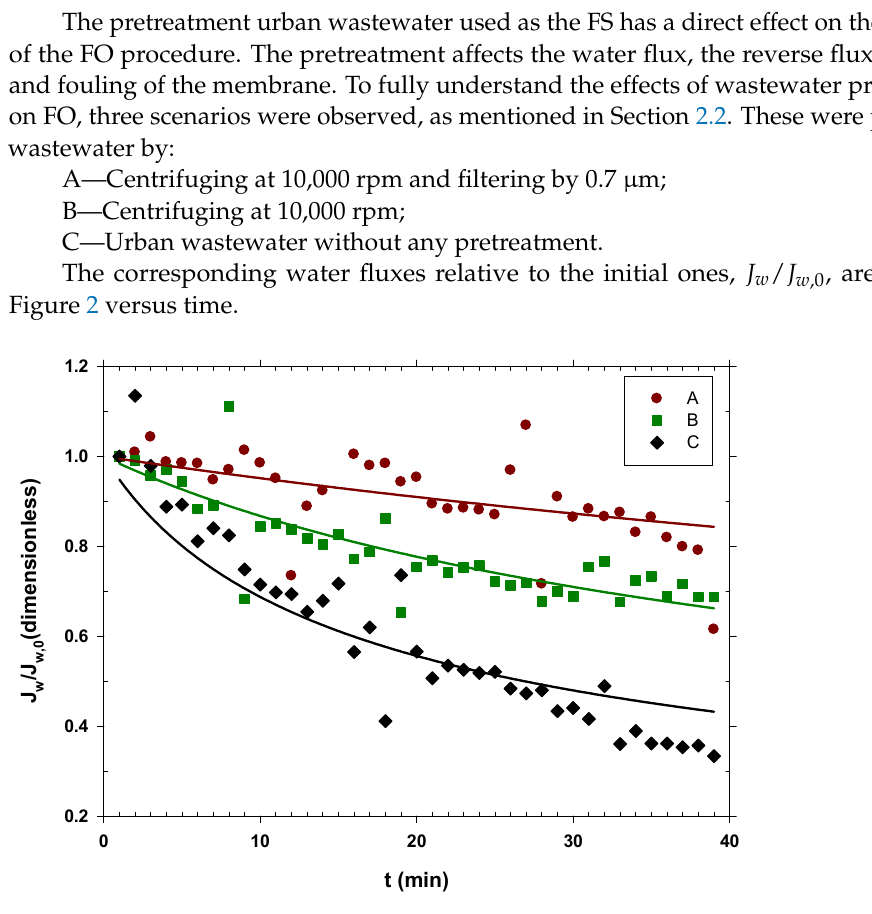
Figure 2. J w / J w ,0 in time with different pretreatments of urban wastewater. A, centrifuged at Figure 2. (cid:1836) (cid:3050) /(cid:1836) (cid:3050),(cid:2868) in time with different pretreatments of urban wastewater. A, centrifuged at 10,000 rpm and filtered by a filter with 0.7 µm pores; B, centrifuged at 10,000 rpm; C, urban wastewater 10,000 rpm and filtered by a filter with 0.7 µ m pores; B, centrifuged at 10,000 rpm; C, urban wastewater without any pretreatment. without any